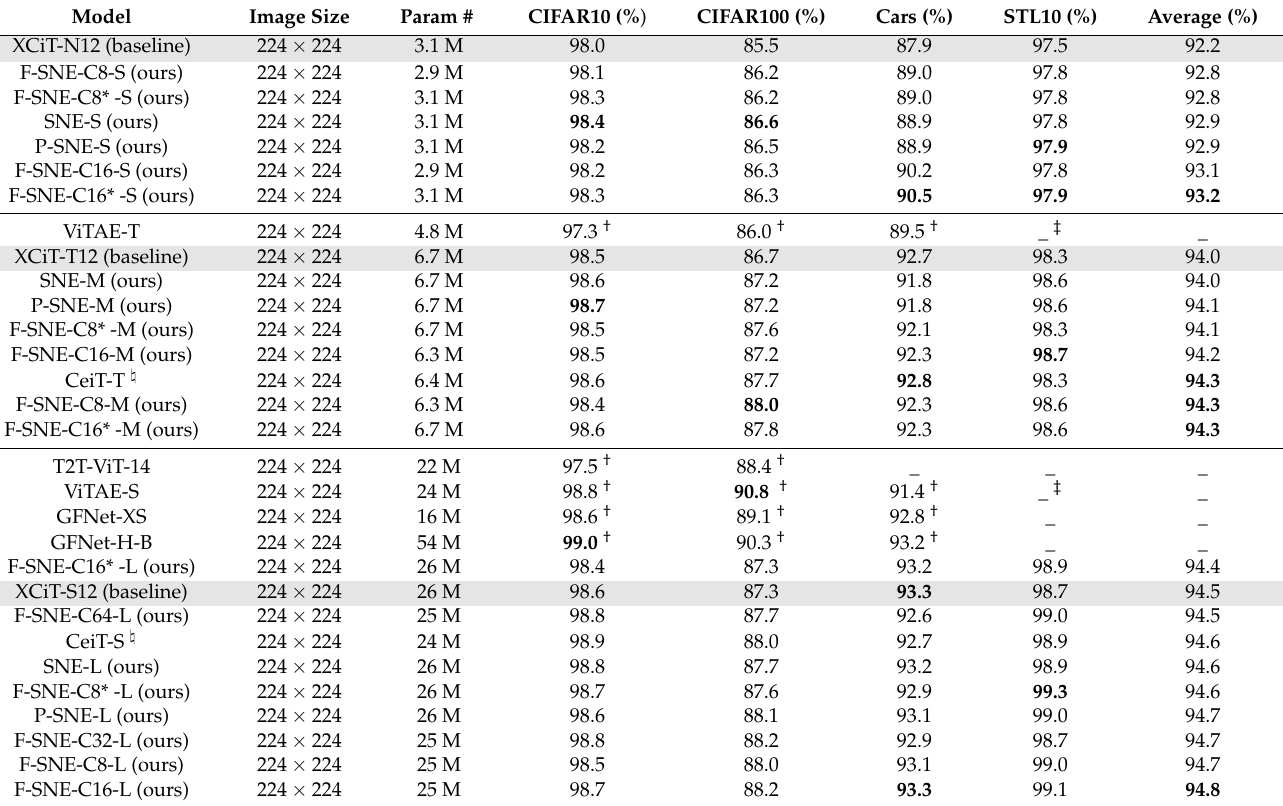
Table 6. Proposed models were evaluated on transfer learning task as below. All models were pre- trained using the ImageNet-1k dataset. † indicates the results are obtained from the paper. ‡ indicates that the experiment could not be performed because of a lack of source code. (cid:92) indicates the use of additional data augmentation, specifically repeated augmentation